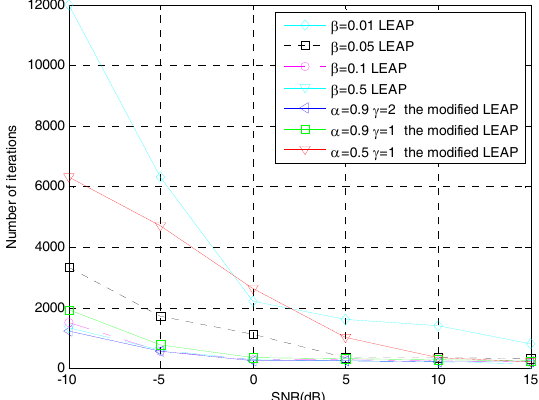
Figure 7. Number of iterations for network convergence of the original LEAP and the modified LEAP